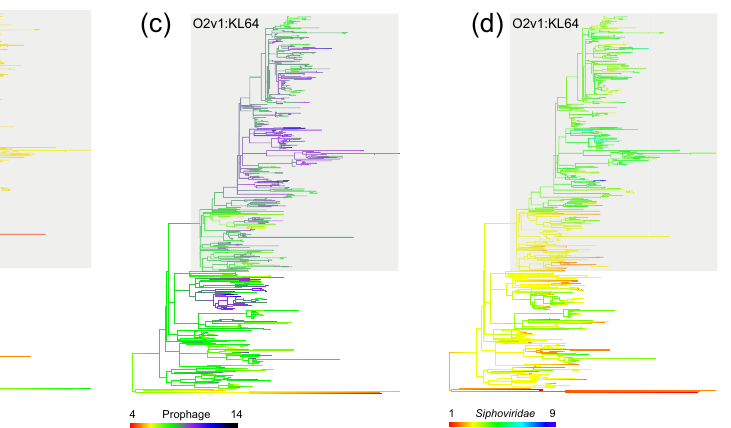
plasmid replicons ( a ), IS copies ( b ), prophages ( c ), and Siphoviridae prophages ( d ) identi fi edpergenome.ColorsareassignedbasedonthenumberofMGEsdetected per genome, as indicated by the bars. The O2v1:KL64 subclone is highlighted by a gray box. Source data are provided as a Source Data fi le.